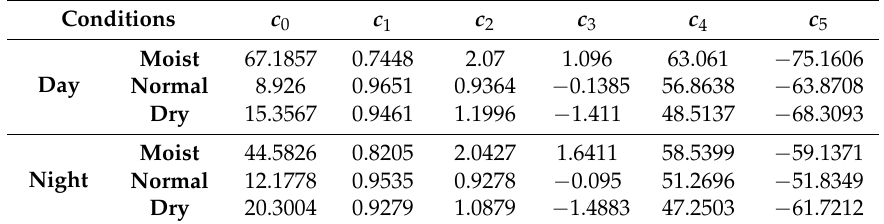
Table 2. Coefficients of Himawari-8/AHI LST retrieval coefficients according to the